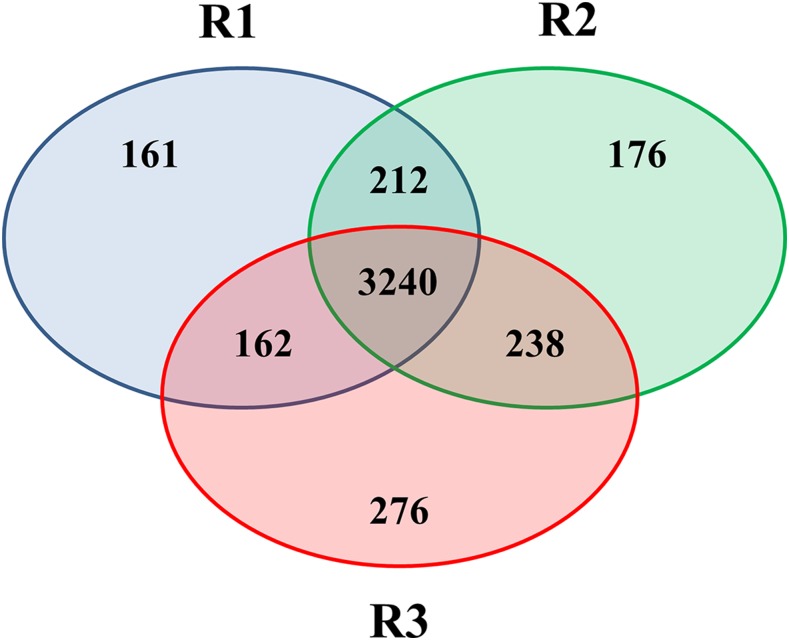
Venn diagram showing the number of identified proteins in experiments R1, R2, and R3. Quantitative data were only used if a given protein was identified in at least two experiments, resulting in quantitative information for 3852 proteins.